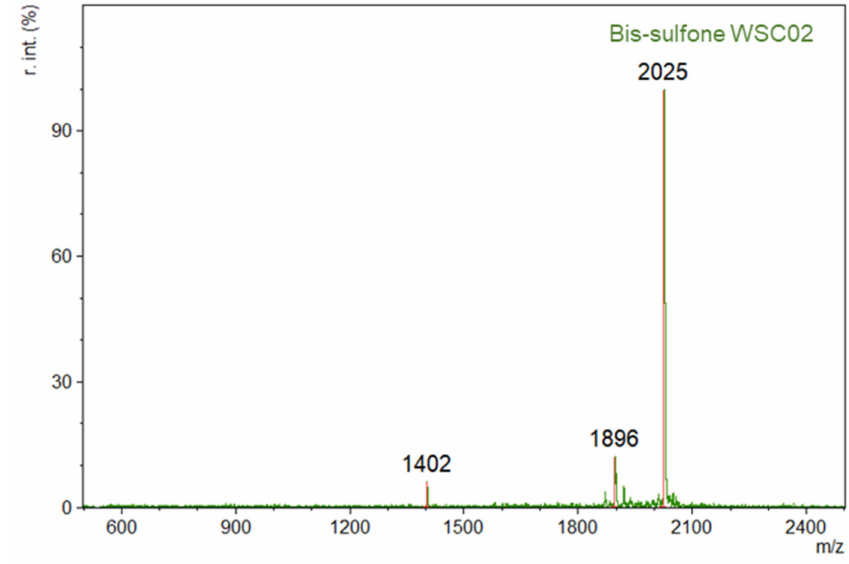
Figure A2. MALDI-TOF-MS of bis-sulfone-WSC02 (+), m/z: [M + H] + = 1869 (monosulfone), [M + H] + = 2025